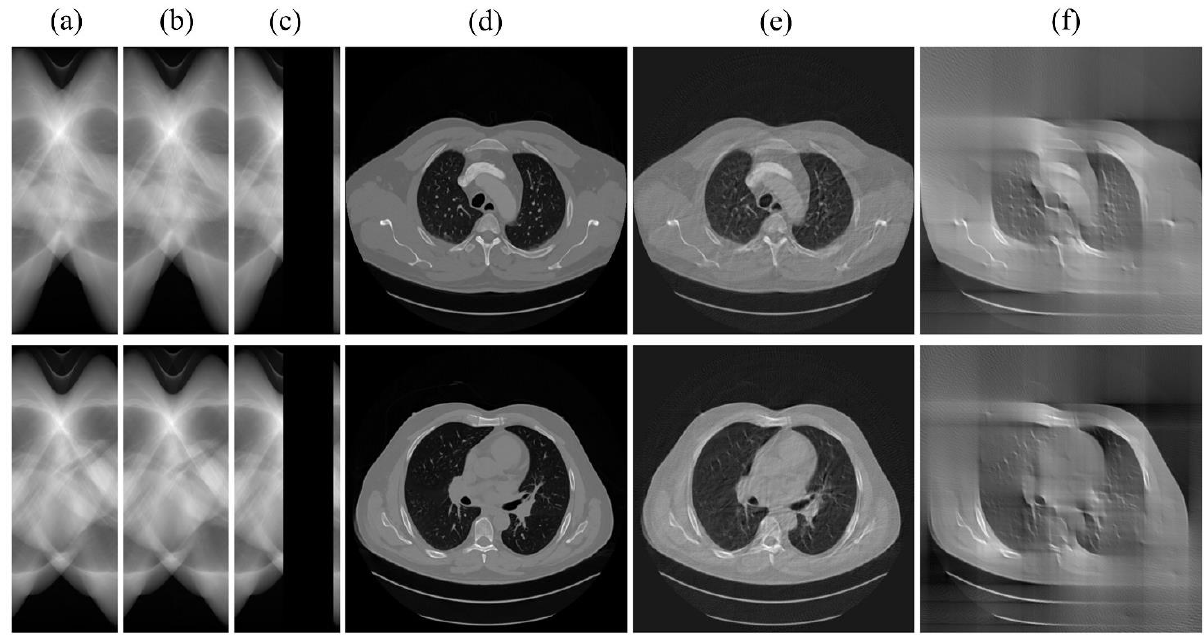
Figure 4. Averaged PSNR, SSIM, and RMSE Indicator values versus the number of epochs for SI- GAN and AR-GAN based on the [0 ,90 ] projection data reconstruction training from lung data.